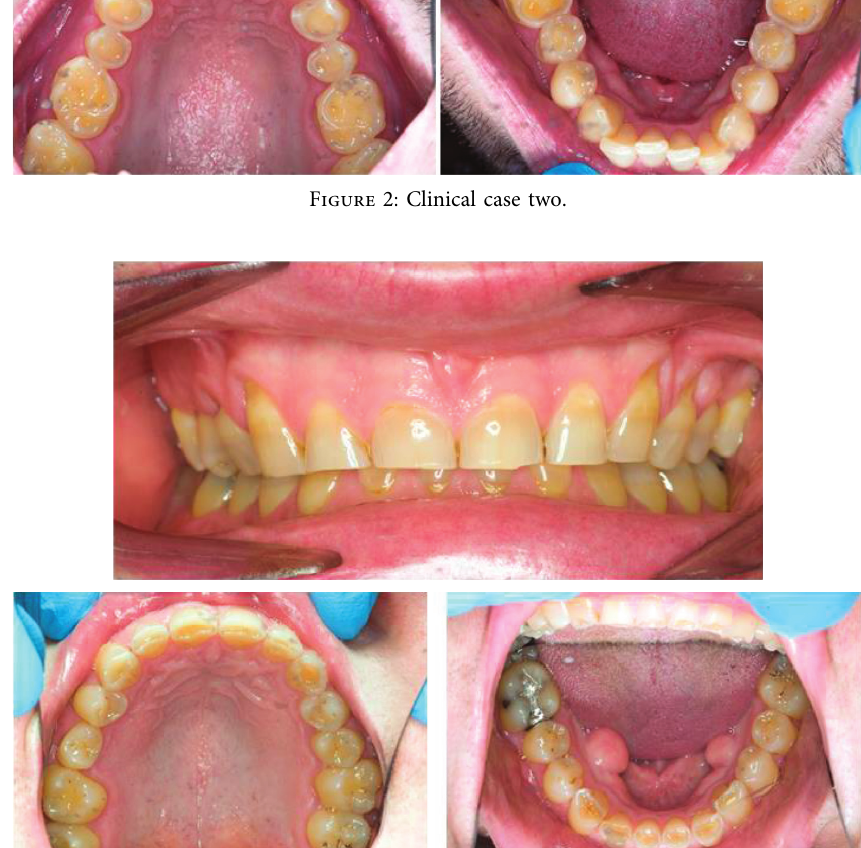
Figure 3: Clinical case